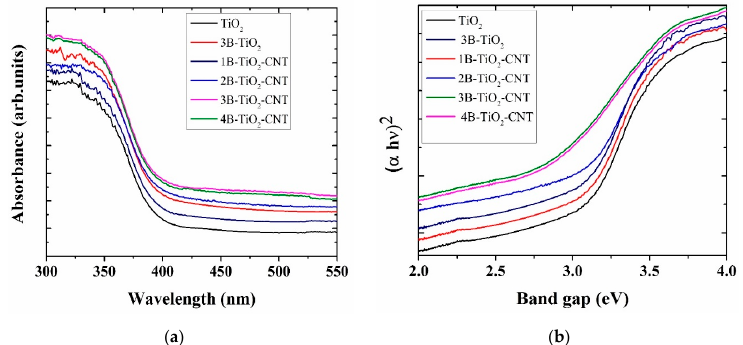
Figure 2. ( a ) UV–vis DRS spectra of TiO 2, 3B-TiO 2, and B-TiO 2 -CNT nanocomposites; ( b ) Tauc plots for bandgap energy estimation of TiO 2 , 3B-TiO 2, and B-TiO 2 -CNT nanocomposites.